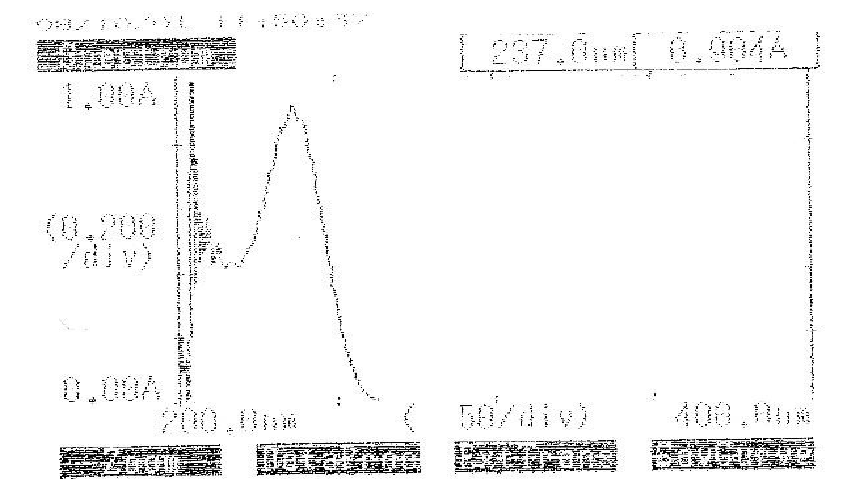
Figure 2. System suitability for metformin HCl